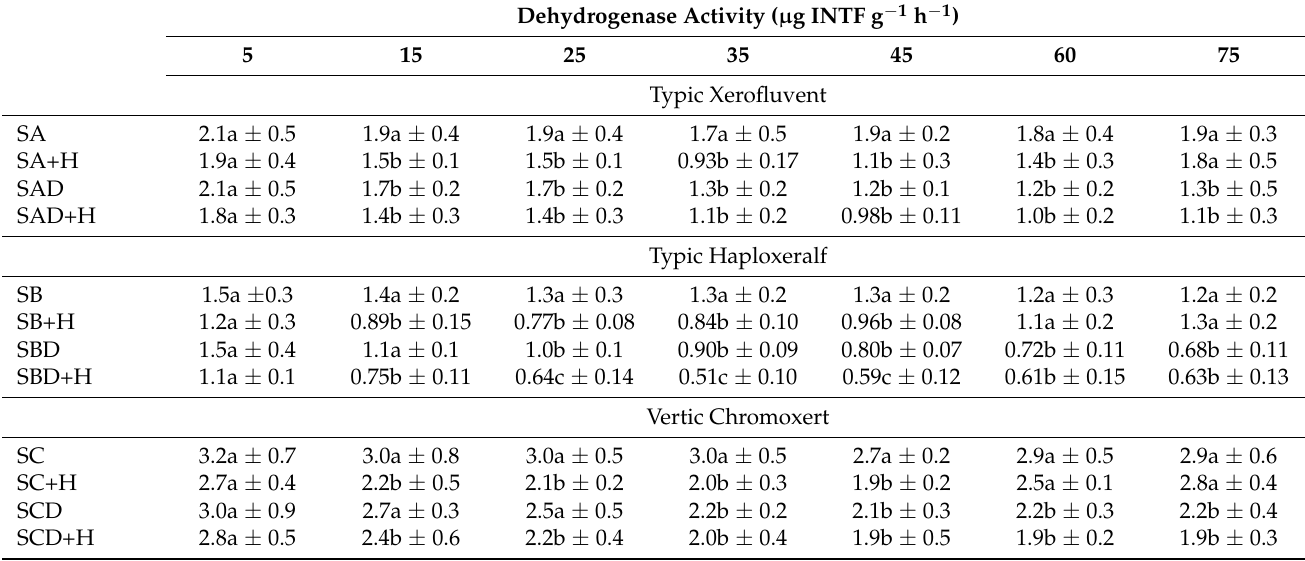
Table 2. Evolution of dehydrogenase activity (mean ± standard error, n = 3) in watered and non- watered soils with MCPA during the experiment.